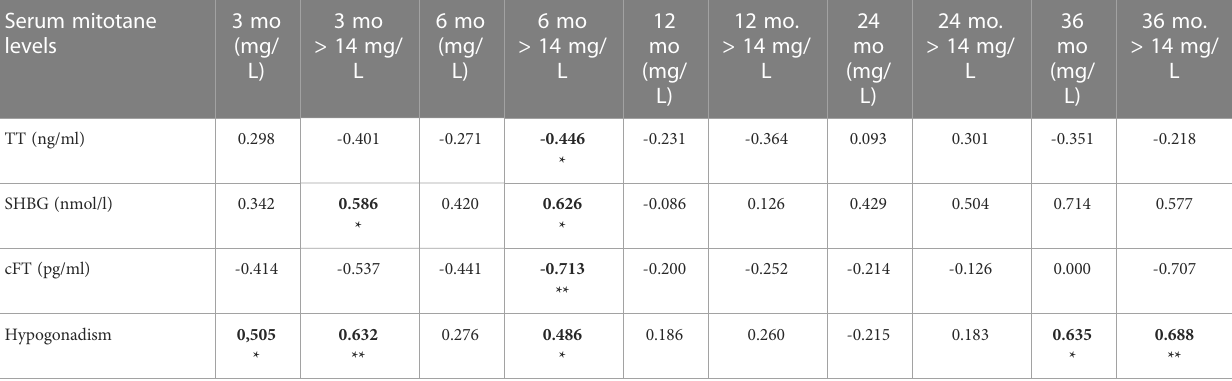
Correlation between variableswas performed withSpearman correlation. TT, totaltestosterone; SHBG, sexhormone binding globulin; cFT,calculated free testosterone; mo, months.Number of patients: 3 mo=21; 6 mo=22; 12 mo=17; 24 mo=14; 36 mo=10. *Correlation is signi fi cant at p=0.05 (two-tail). ** Correlation is signi fi cant at p=0.01 (two-tail). signi fi cant data in bold.